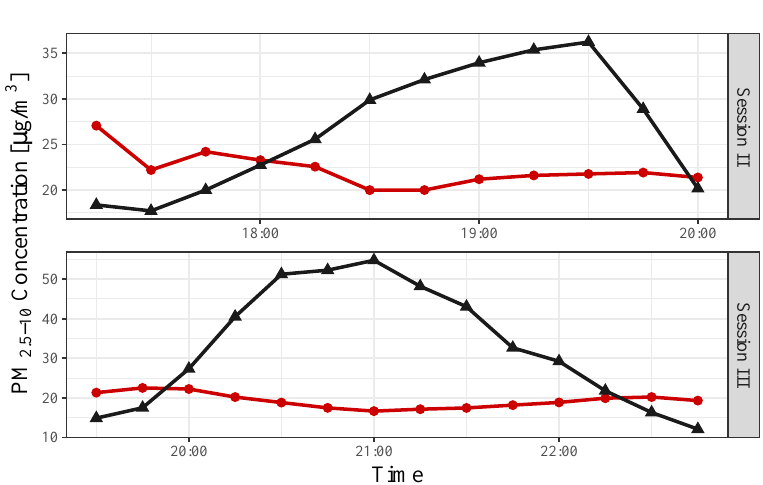
Figure 7. Indoor and outdoor PM 2.5–10 mass concentration time series.